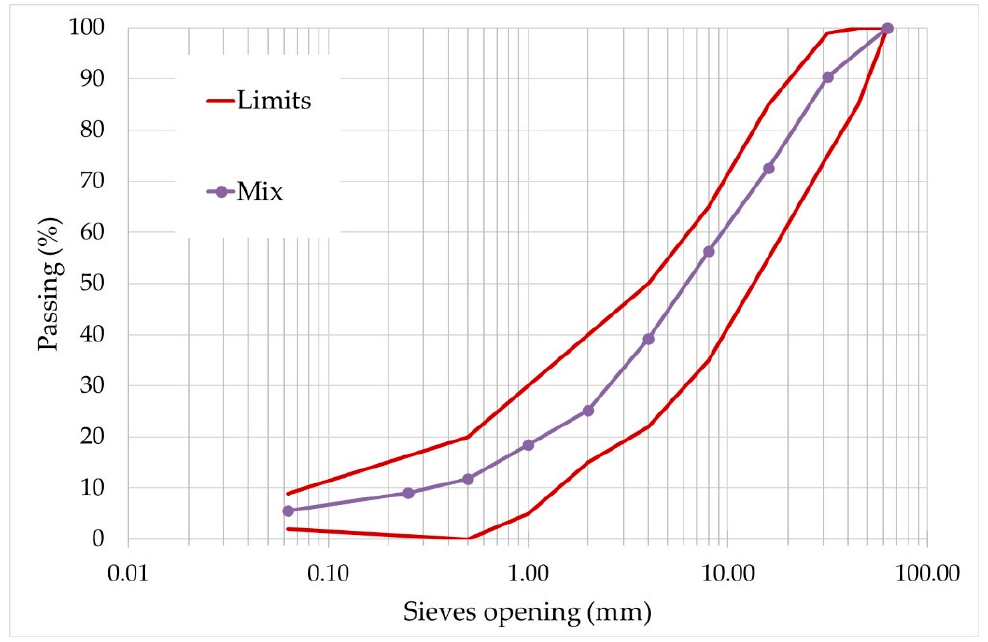
Figure 4. Particle size distribution and grading envelope 0/31.5 GA, for road foundations of CDW.